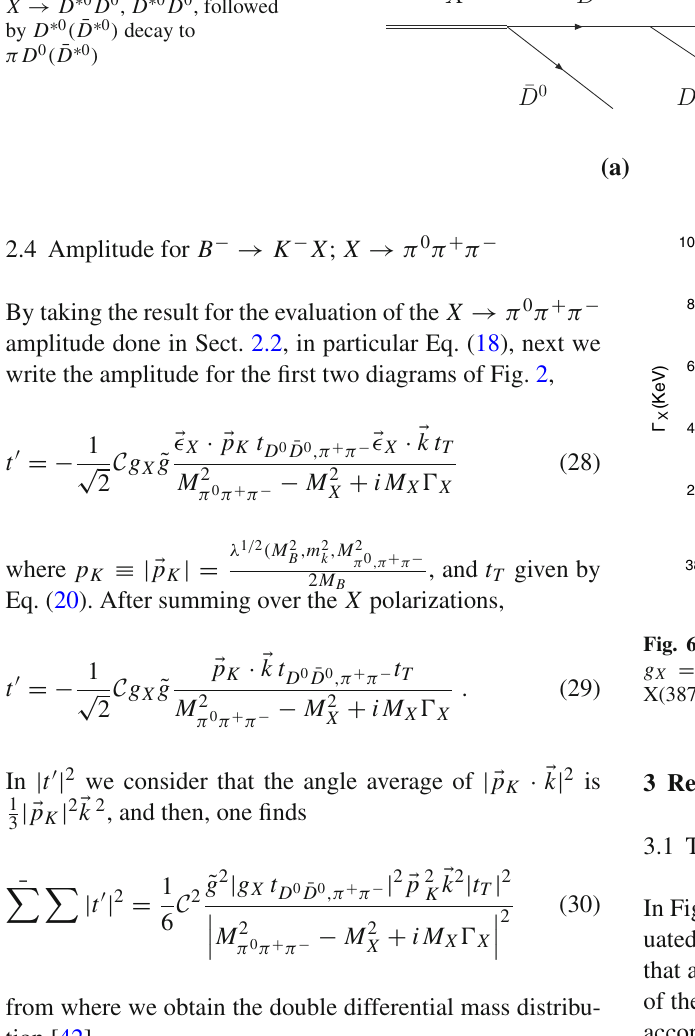
Fig. 5 Diagrams for X → D ∗ 0 ¯ D 0 , ¯ D ∗ 0 D 0 , followed by D ∗ 0 ( ¯ D ∗ 0 ) decay to π